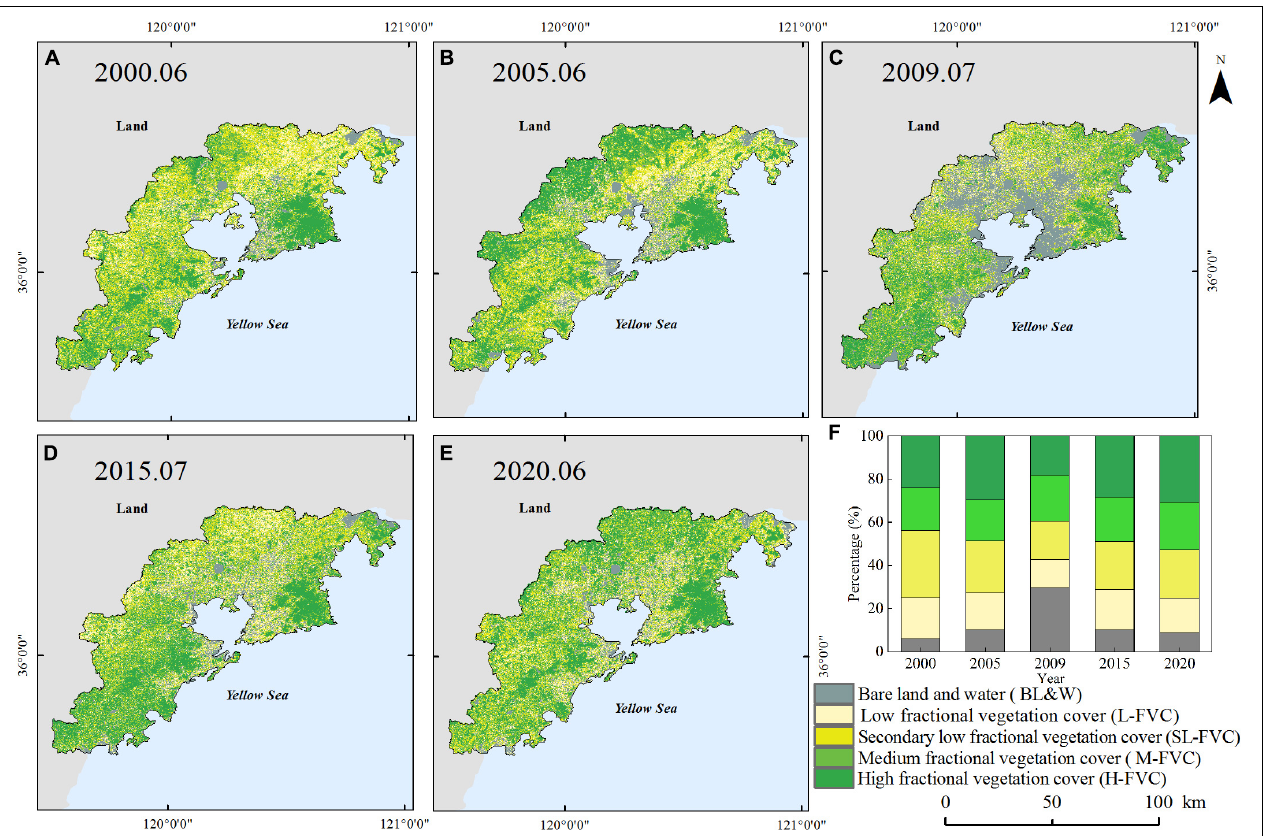
FIGURE 4 | Classification of fractional vegetation cover in summer from 2000 to 2020 (A) 2000.06, (B) 2005.06, (C) 2009.07, (D) 2015.07, (E) 2020.06, and (F) the percentage of different classification from 2000 to 2020.